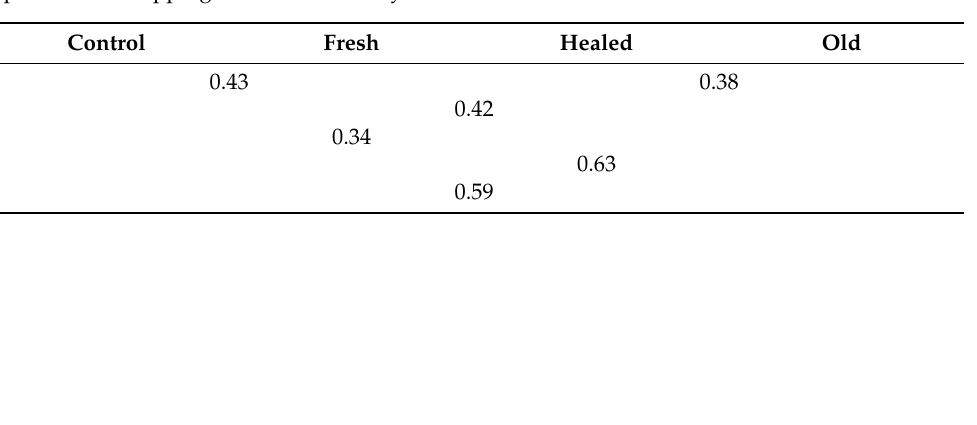
Table 6. Sørensen’s β -biodiversity index comparing the similarity of mycobiota inhabiting different types of bark-stripping wounds caused by red deer on silver fir in the Gorce National